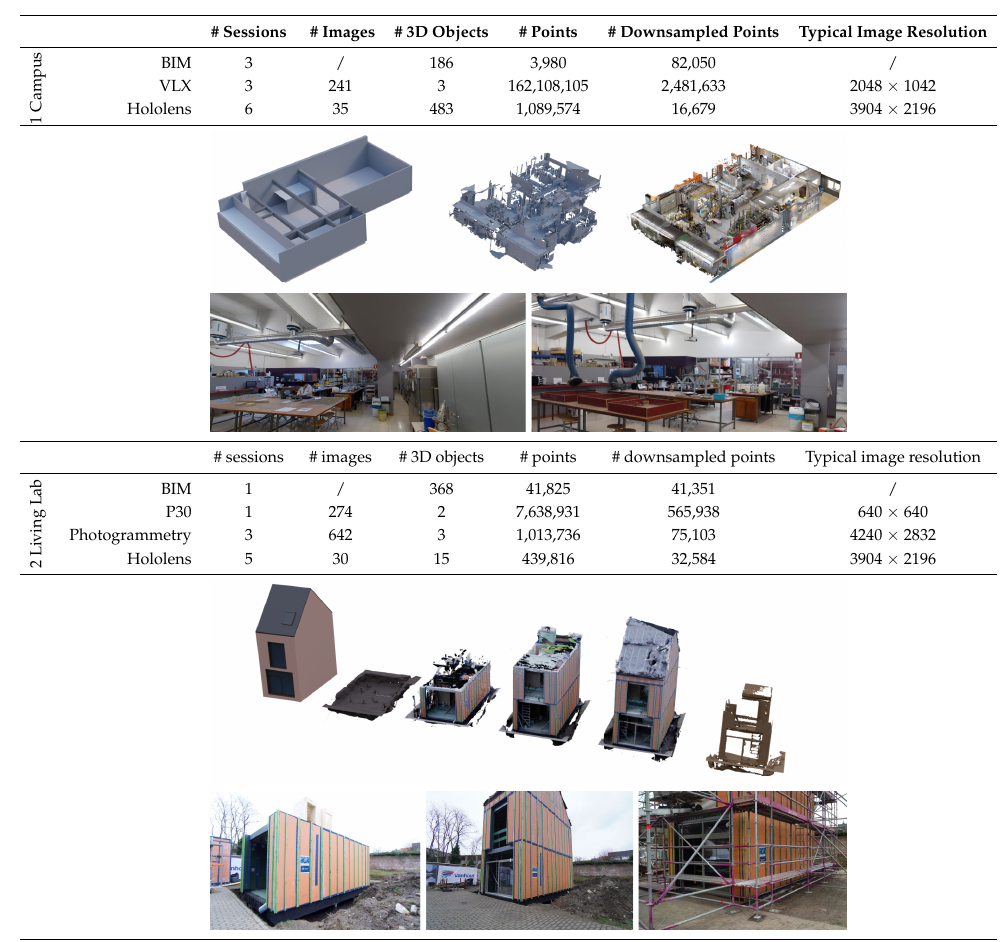
Table 1. Overview of the provided reference data of test cases 1 and